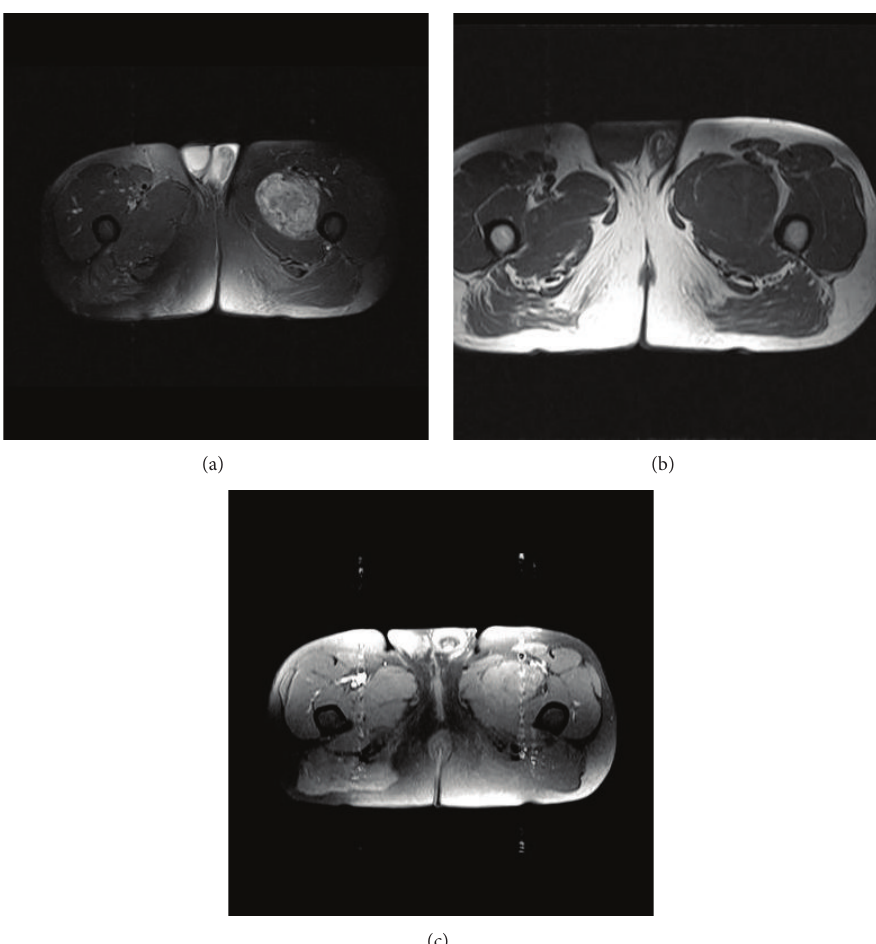
Figure1:(a)AxialT1-weightedTSEimageshowsahypointenseintermuscularmass.(b)Themassisinhomogenouslyhyperintenseonanaxial T2-weighted TSE fat suppressed image. (c) Axial T1-weighted TSE image with fat suppression after intravenous administration of gadolinium exhibits faint in homogenous enhancement of the lesion.